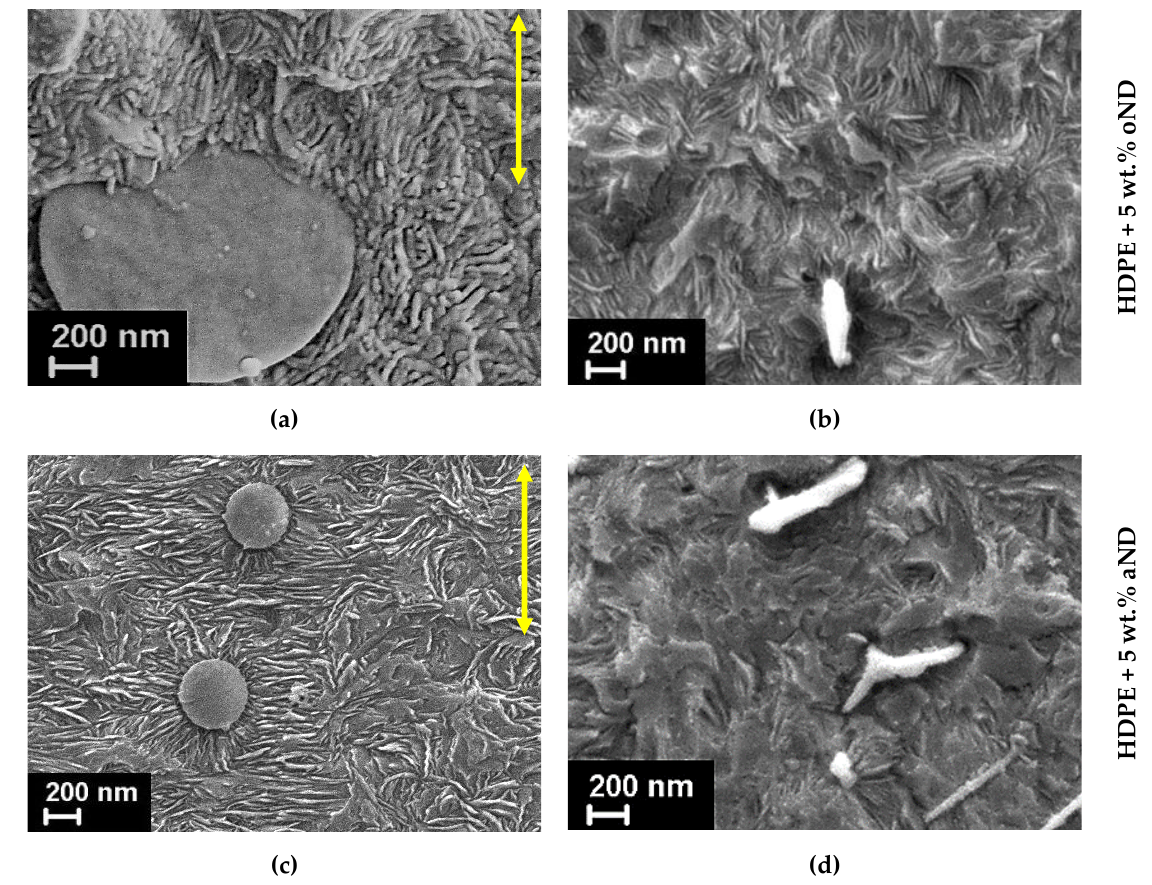
Figure 5. SEM micrographs of the longitudinal (left side — ( a , c )) and transversal (right side — ( b , d )) fracture surfaces of the HDPE-based composite fibers filled with 5 wt. % of the nanodiscs. An arrow indicates the fibers ’ extrusion direction.